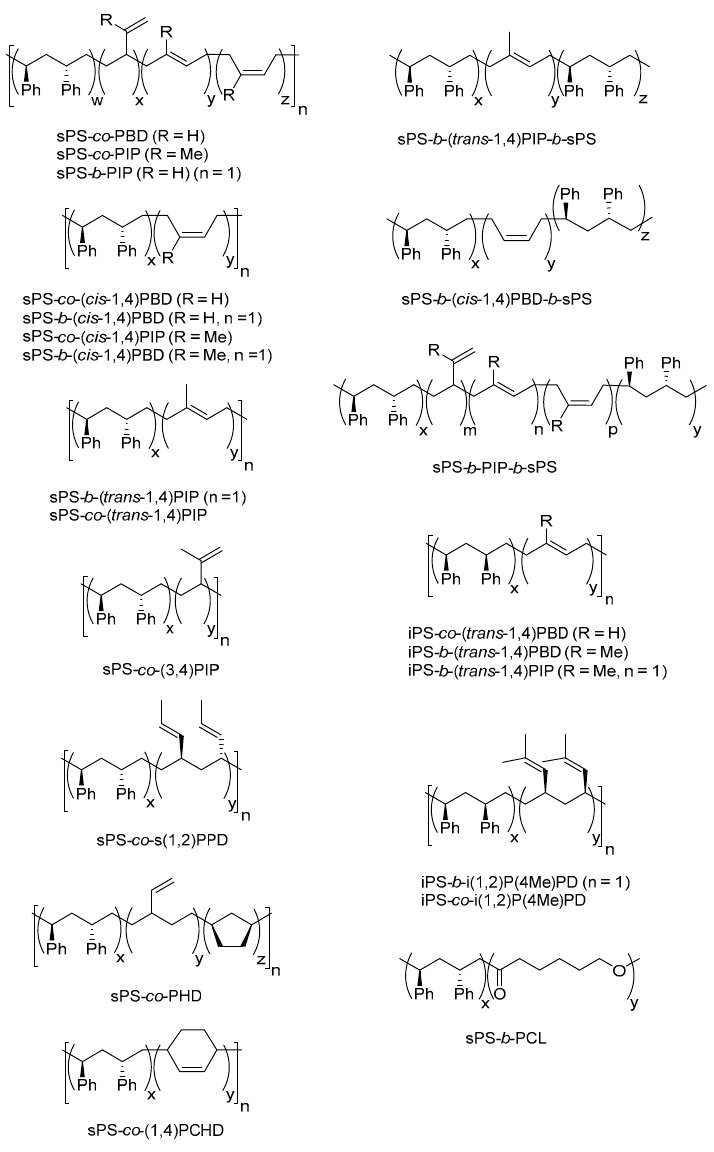
Figure 4. Structure of stereoregular styrene-diene and styrene-caprolactone copolymers.